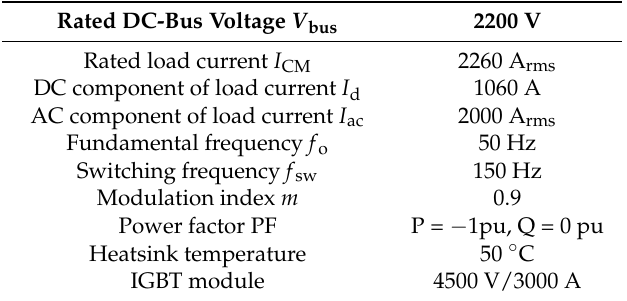
Table 4. Test Parameters of Full-bridge